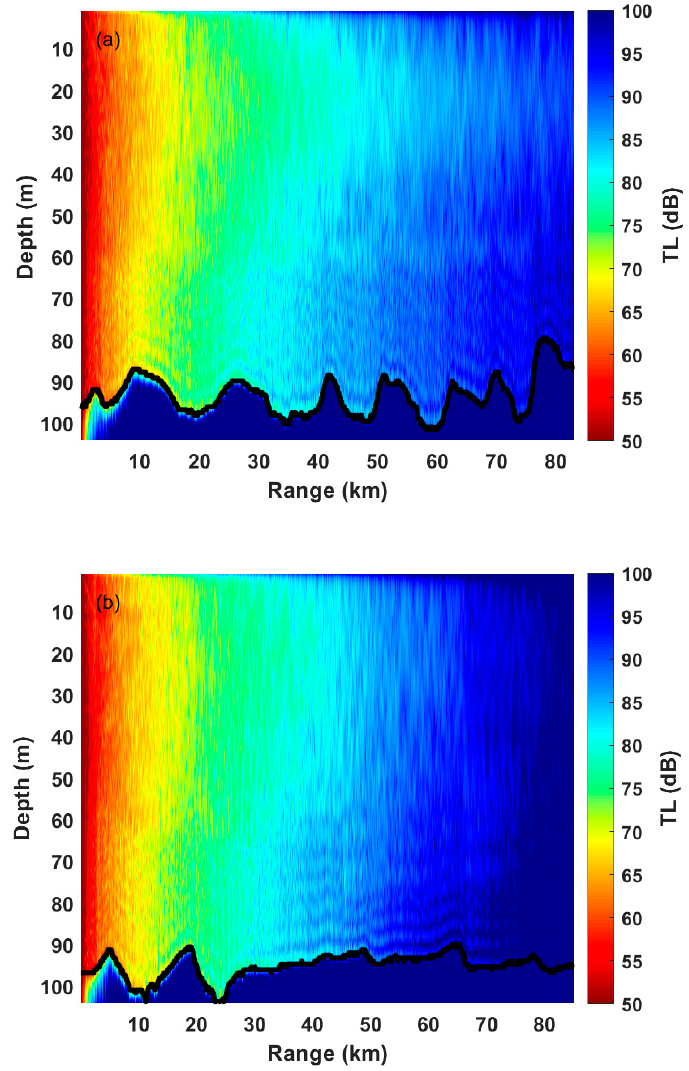
Figure 14. The numerical two-dimensional TL for T1O ( a ) and T3O ( b ), for central frequency 1000 Hz and source depth 7 m.